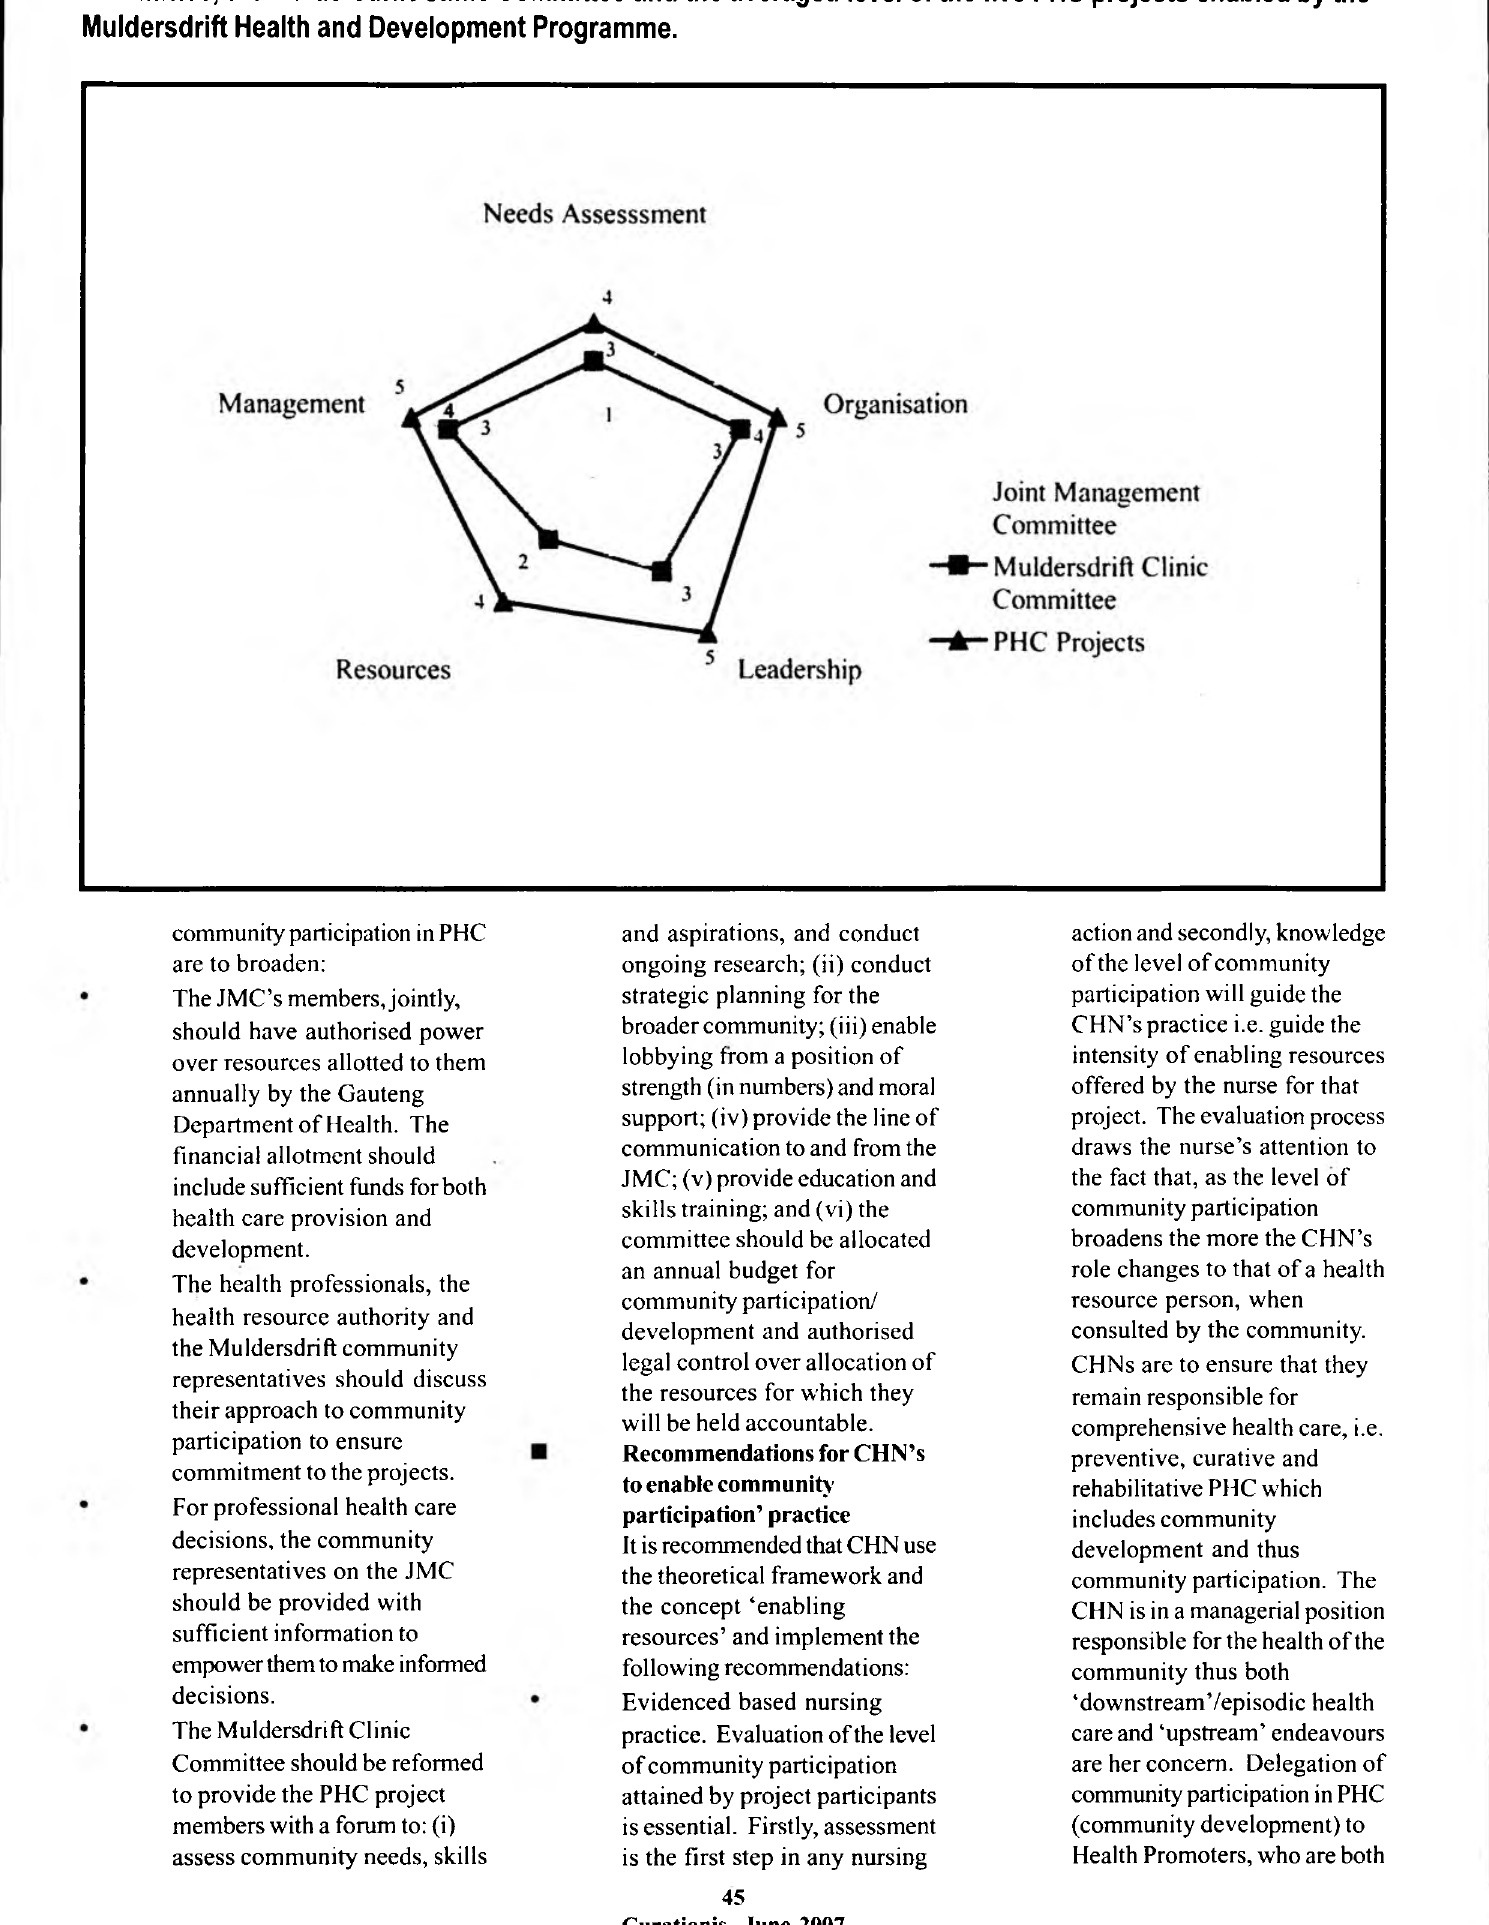
Figure 4. Comparative graph of the levels of community participation achieved by the Joint Management Committee, the Muldersdrift Clinic Committee and the averaged level of the five PHC projects enabled by the Muldersdrift Health and Development